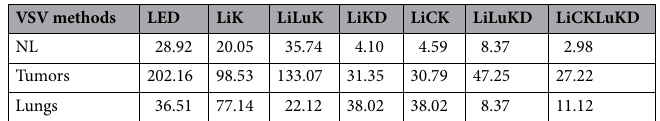
Table 5. MAE of differential DVH by VSV methods in different VOIs compared with MC.